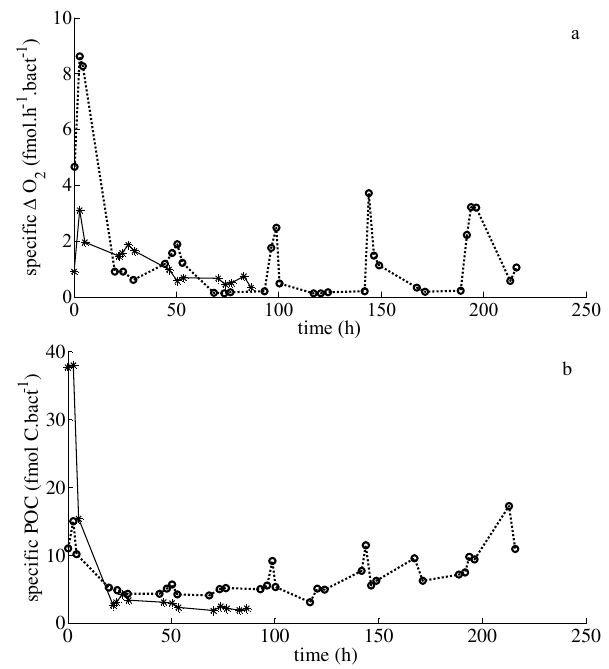
Fig. 3. Dynamics of (a) specific O 2 consumption (fmolh − 1 bact − 1 ) estimated as the ratio between O 2 consumption rate and bacterial density and (b) specific POC (fmolCbact − 1 ) estimated as the ratio between POC concentration and bacterial density for the SA (*) and the P ( (cid:13) ) experiments. Data points are connected by solid and dotted lines for the SA and P experiment, respectively.